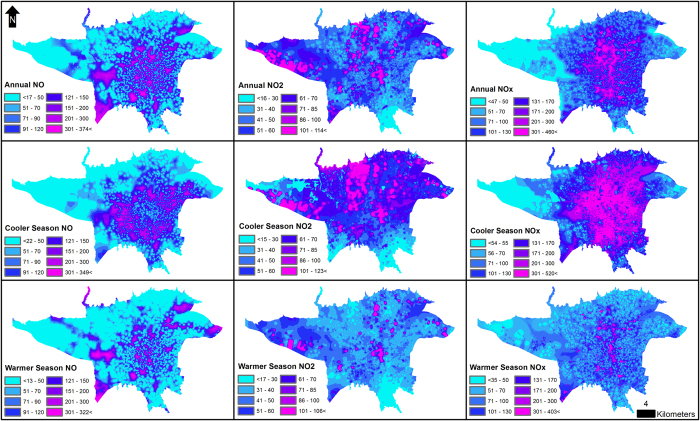
Estimated annual, cooler and warmer seasons NO, NO2 and NOX concentrations (ppb) from the final land use regression models in Tehran, Iran, 2010.The prediction resolution is 5 × 5 meters. The figure is generated using ESRI’s ArcGIS 10.2.1 for Desktop (ESRI, Redlands, CA, USA, http://www.esri.com/).